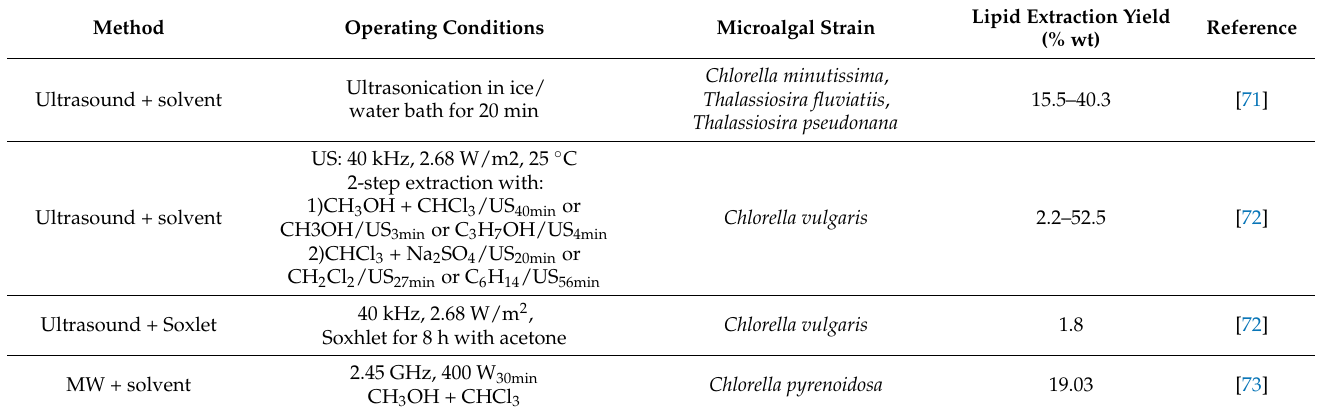
Table 2. Summary of conventional and novel methods for lipid extraction from algal cells.